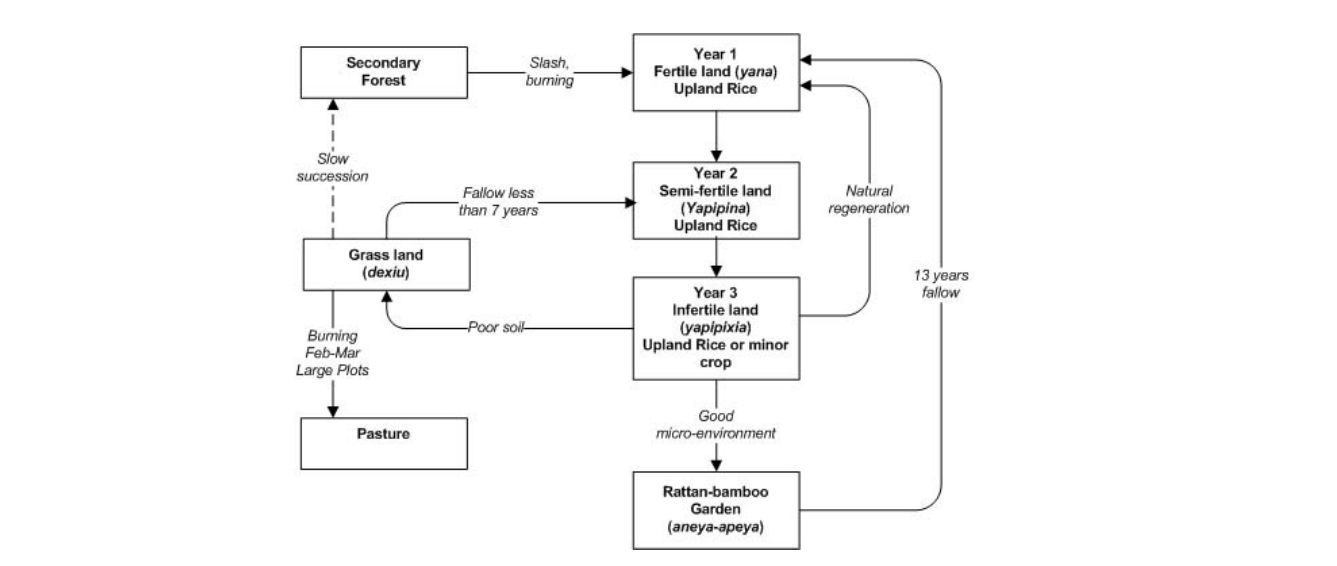
Figure 3. Hani taungya swidden-fallow management in